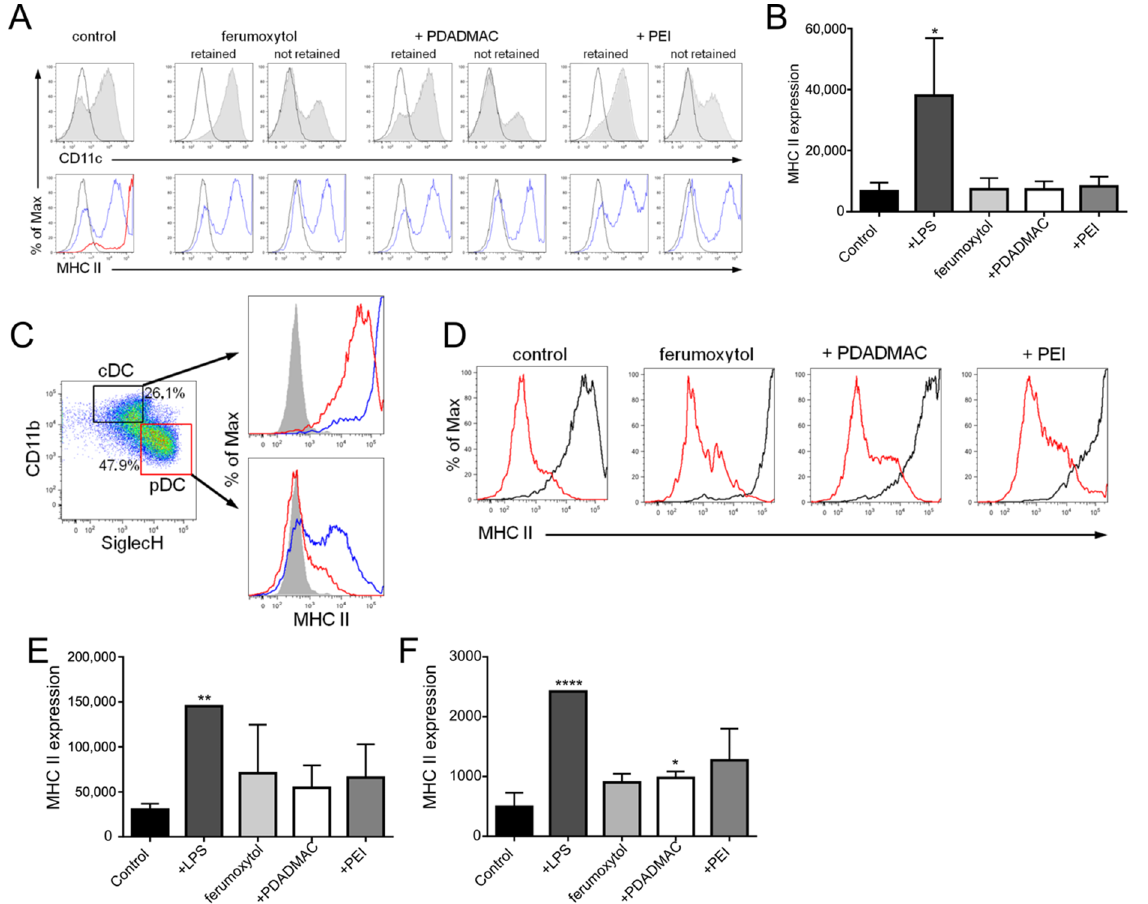
Figure 6. Immunophenotype of inflammatory and steady-state DCs upon MNP uptake. MHC II expression as a measure of DC activation was analyzed 24 h after MNP labeling and magnetic sorting by flow cytometry. Unlabeled cells were used as controls displaying an immature phenotype. LPS stimulation of cells for 24 h was used as a control for DC activation. Representative data from at least 3 independent experiments are shown. ( A ) Surface antigen expression of CD11c (gray histograms) and MHC II (open blue histograms) on MNP-labeled GM-DCs. Activation of unlabeled DCs with LPS is depicted in red. Open black histograms show isotype control staining. ( B ) Bar diagram shows the geometric mean of fluorescence intensity (geoMFI) values for MHC II expression ± SD on GM-DCs. (C-F) MHC II expression on MNP-labeled cDCs and pDCs. ( C ) DC subsets were identified according to CD11b and SiglecH expression and the MHC II expression (open red histograms) was determined within specific DC subsets as before (see Figure 2B). Gray histograms show isotype control staining. Activation of unlabeled cDCs and pDCs by LPS is depicted in blue. ( D ) MHC II expression on unlabeled and MNP-labeled cDCs (open black histograms) and pDCs (open red histograms). Results of MHC II expression on cDCs ( E ) and pDCs ( F ) are shown as geoMFI values ± SD (* p < 0.05, ** p < 0.01, **** p < 0.0001).